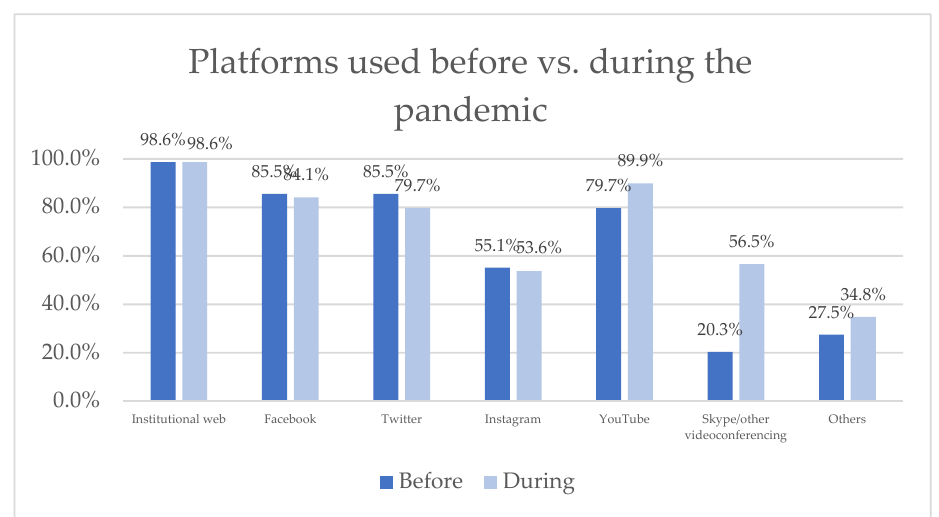
Figure 3. Digital platforms used by the diocese before vs. after the onset of the pandemic. Source: Authors.